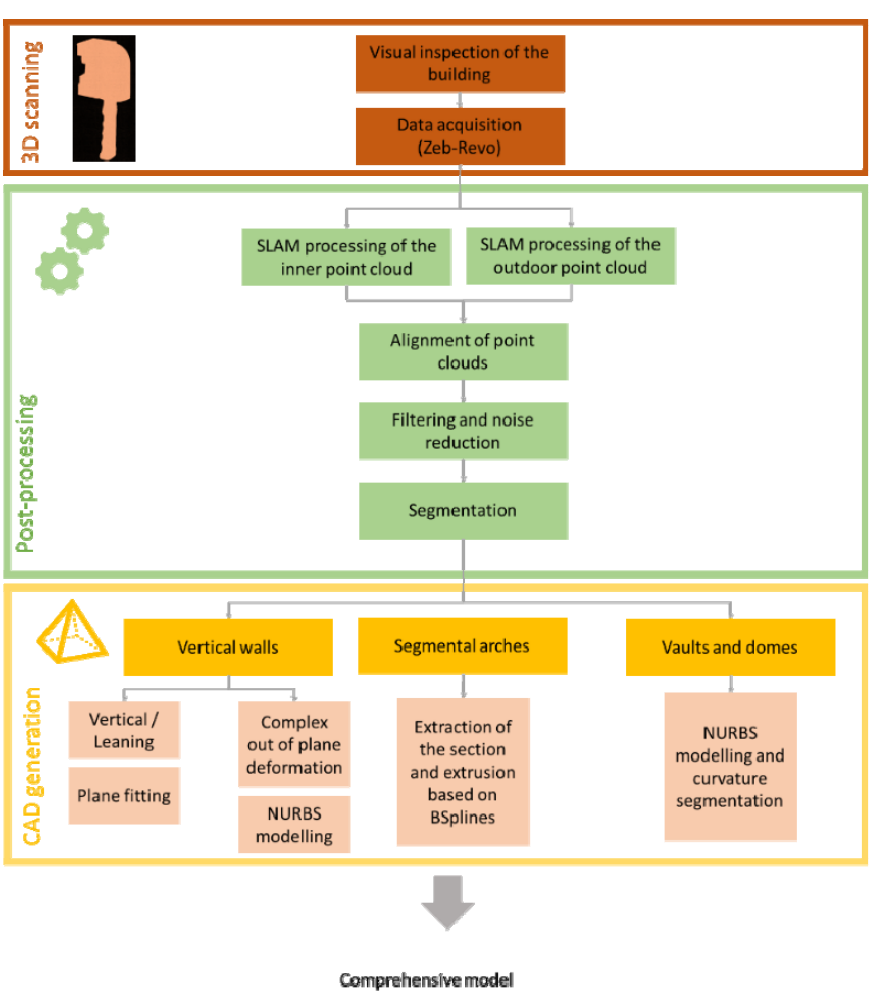
Figure 4. Graphical workflow used for generating a CAD model of the church.